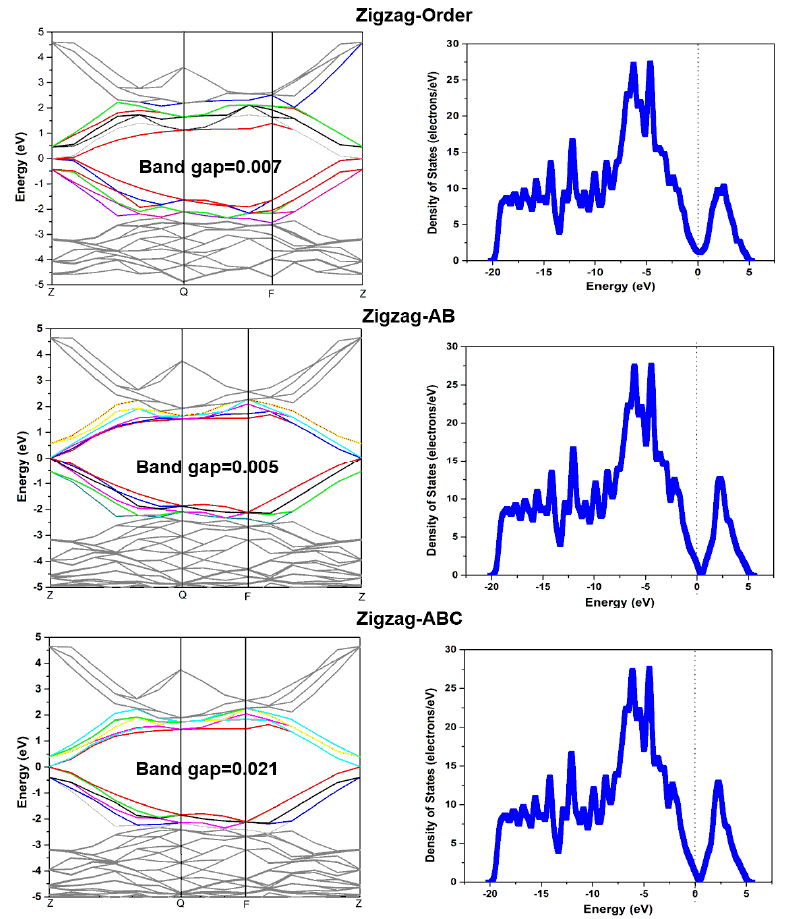
Figure 5. The schematic diagrams of the band structure and the density of states in the three layers of zigzag graphene with Order, AB, and ABC stacking, respectively.